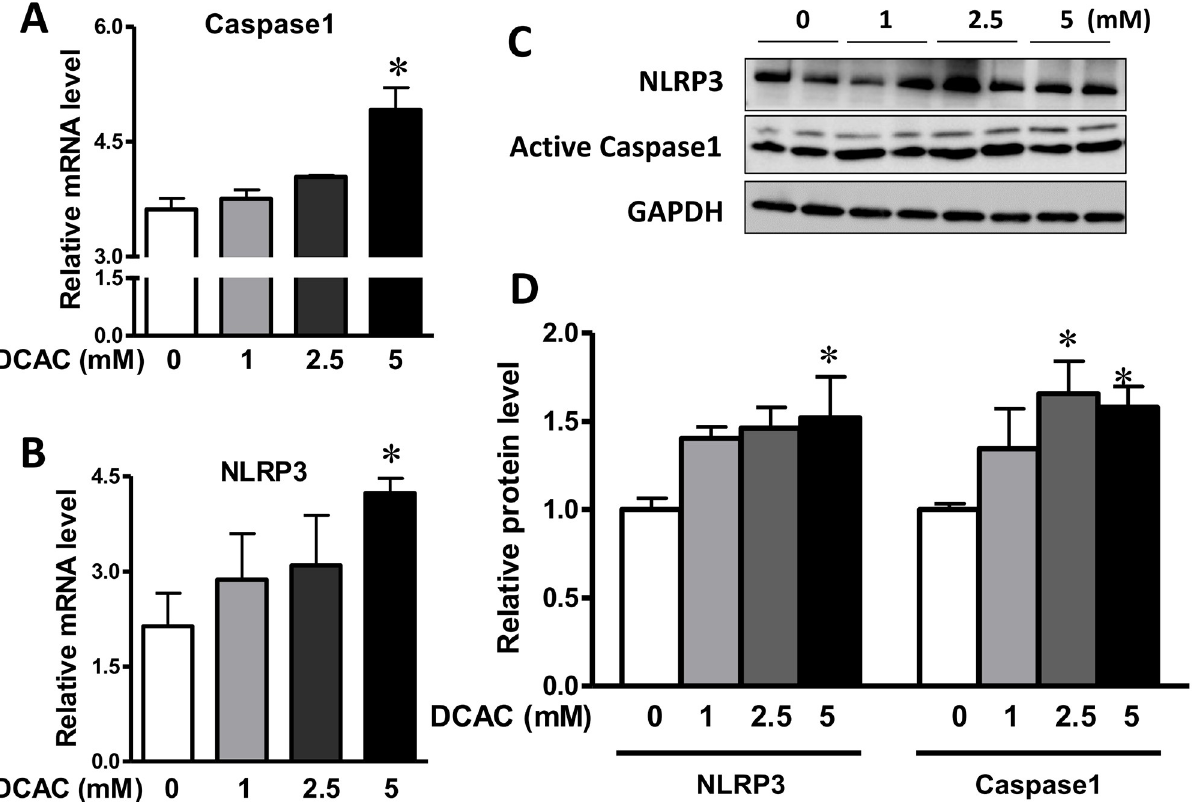
Fig 4. DCAC promoted inflammasome activation in KCs. KCs were pre-treated with DCAC at concentrations of 0, 1, 2.5 or 5 mM for 24 h. qPCR and Western blot analyses were done for the expression of inflammasome (NLRP3 and caspase1). (A, B) mRNA levels of the caspase1 and NLRP3, as measured by RT-PCR, and (C) Relative protein levels of NLRP3 and caspase1, as determined by Western blotting. n = 3 in each group. � p < 0.05 vs. the controls.